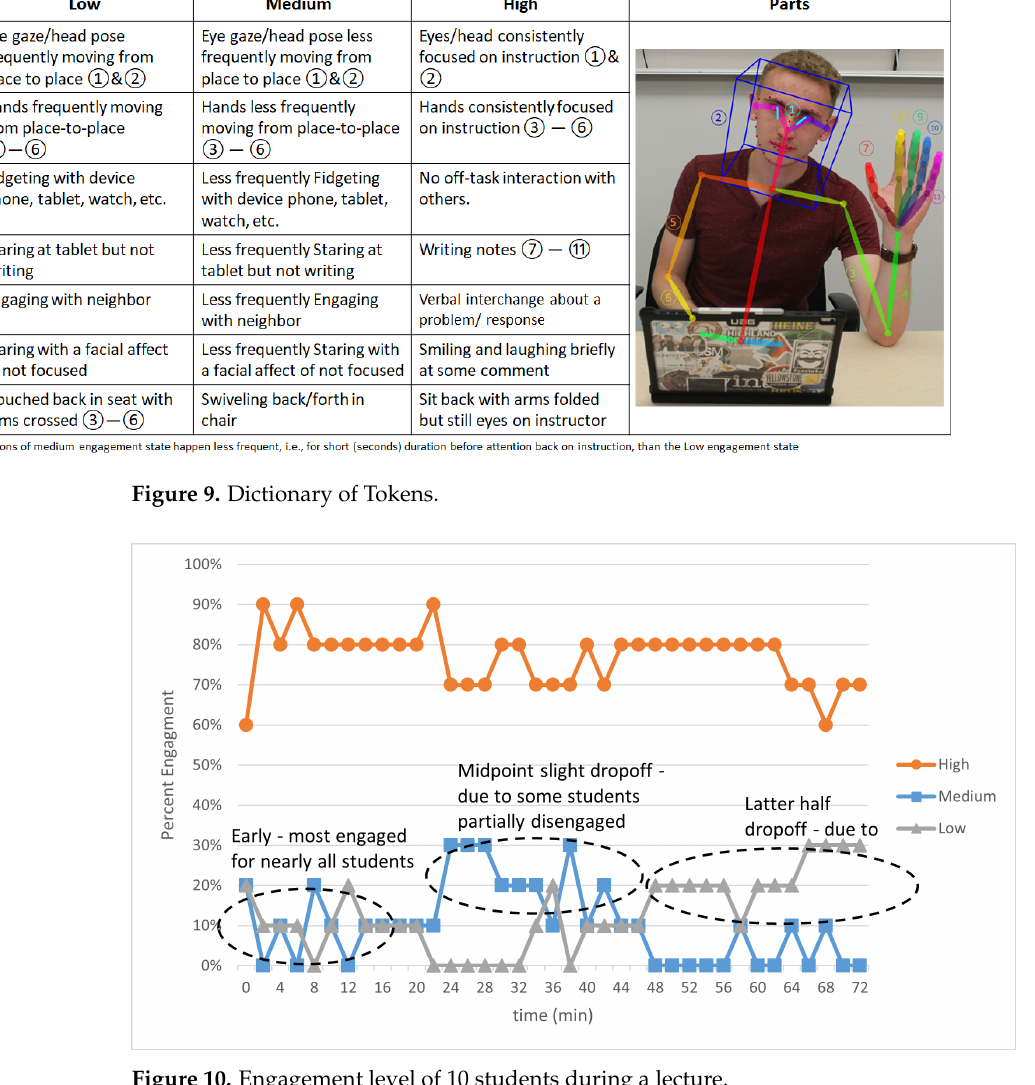
Figure 10. Engagement level of 10 students during a